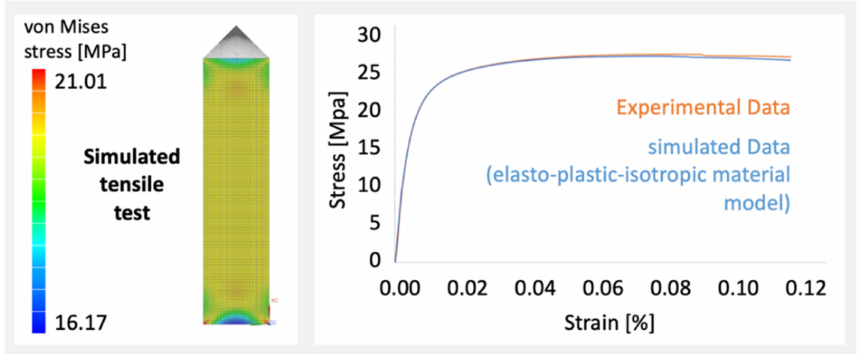
Figure 4. Exemplary validation of the anode material